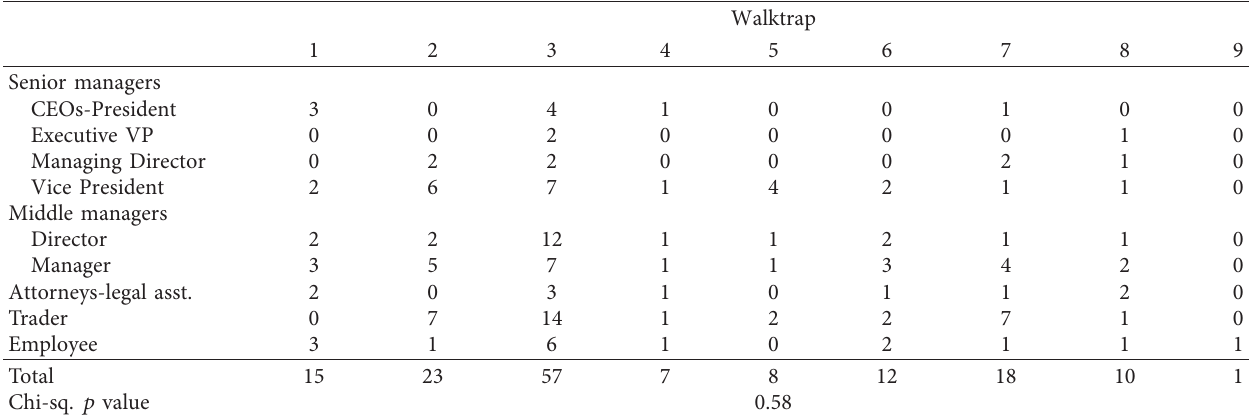
Table 3: Frequency of Enron’s employees by occupational categories according to the clusters discovered (columns) by the Walktrap algorithm [65]. Chi-square’s p value compares the results with the expected values assuming that there is independence between the occupational categories and the clusters generated by each algorithm.